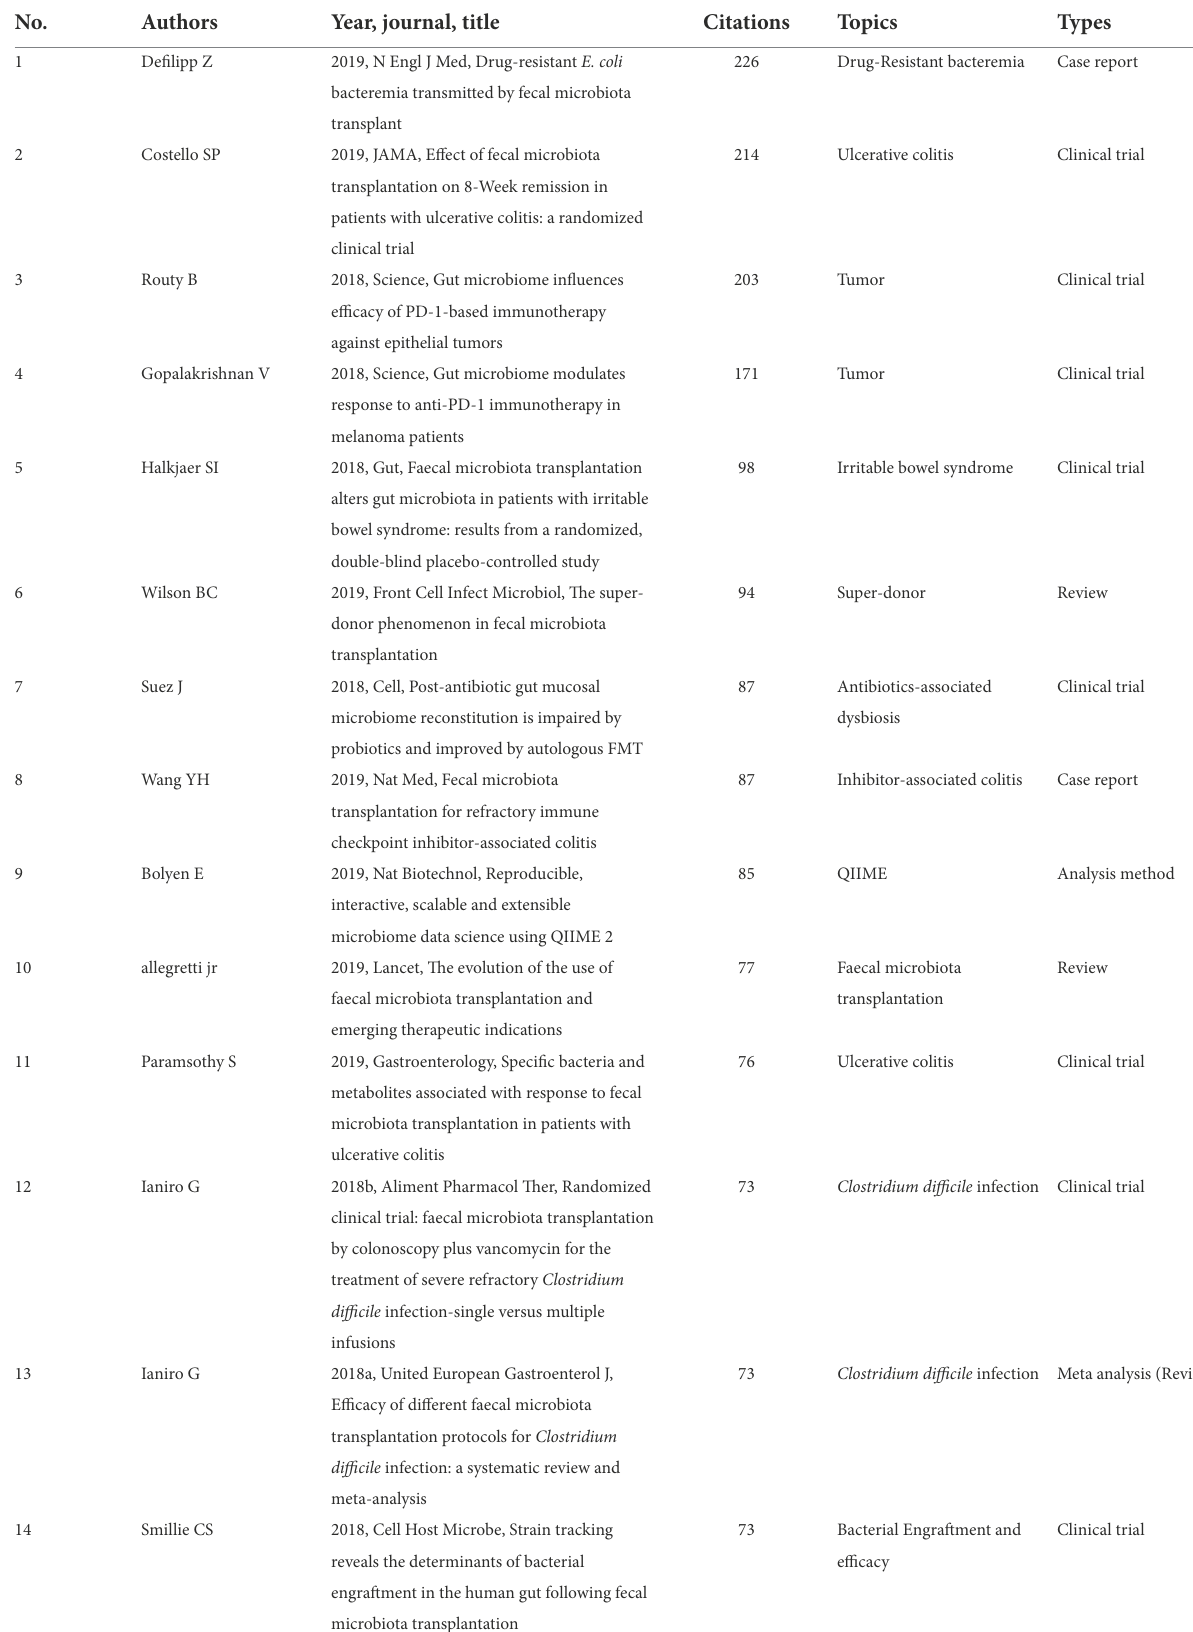
TABLE 5 The top 20 most-cited references published in the last 5 years.